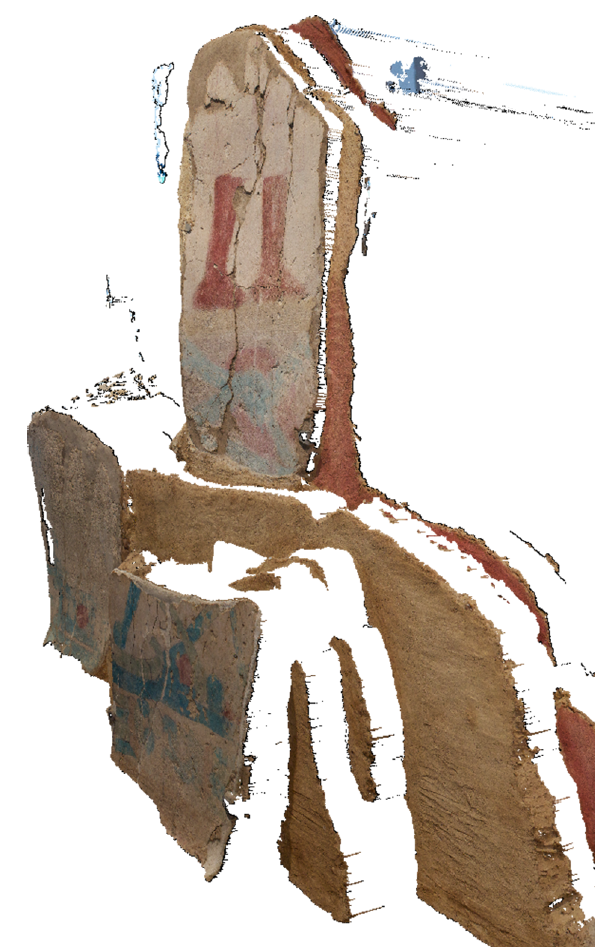
Figure 5. Orthophoto detail (30% of full size)